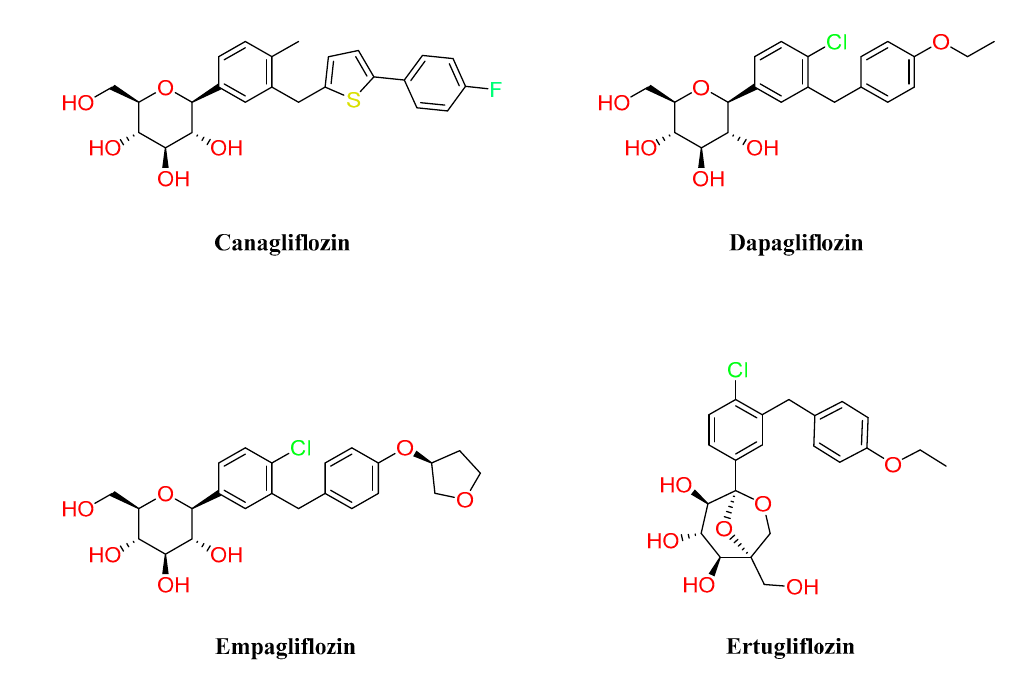
Figure 7. Structures of di ff erent SGLT-2 inhibitors.